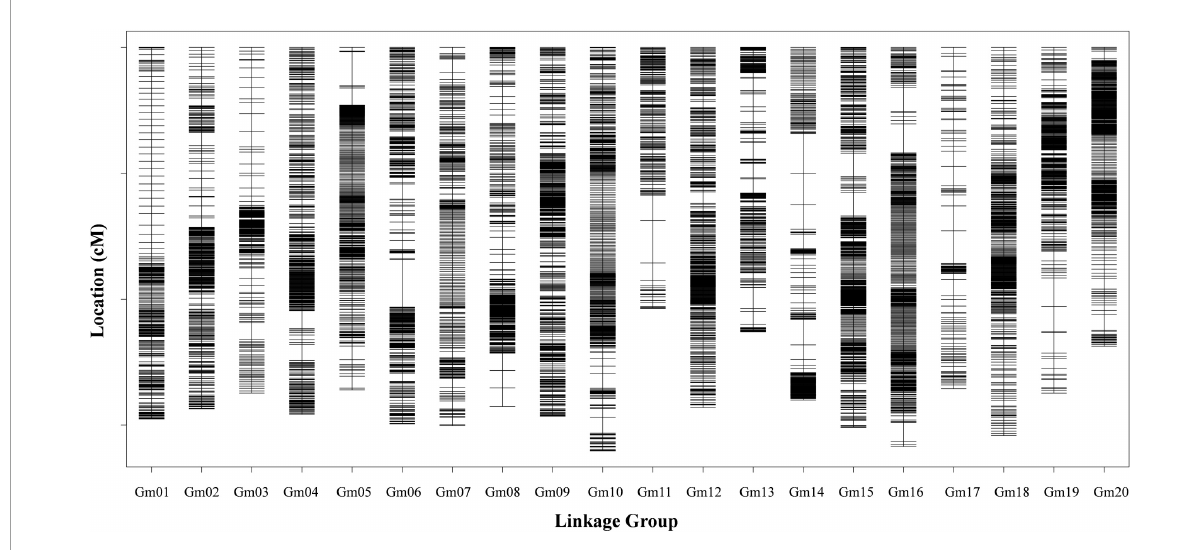
FIGURE1 The soybean high-density genetic map. Bin markers are distributed on 20 chromosomes. The black bars in each linkage group represent the mapped bin markers. The linkage group number is shown on the x -axis and genetic distance is shown on the y -axis (cM is the